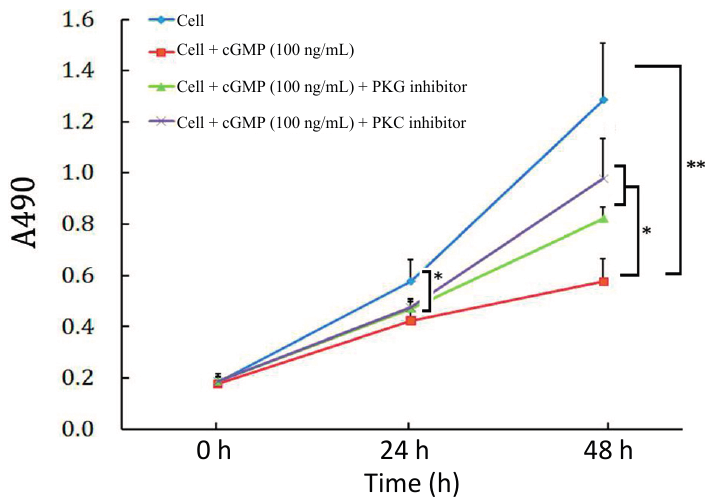
Figure 2. Effects of PKC and PKG inhibitors on cellular proliferation suppressed by cGMP. Cells were pretreated with the PKG inhibitor or PKC inhibitor for 2 h, and then